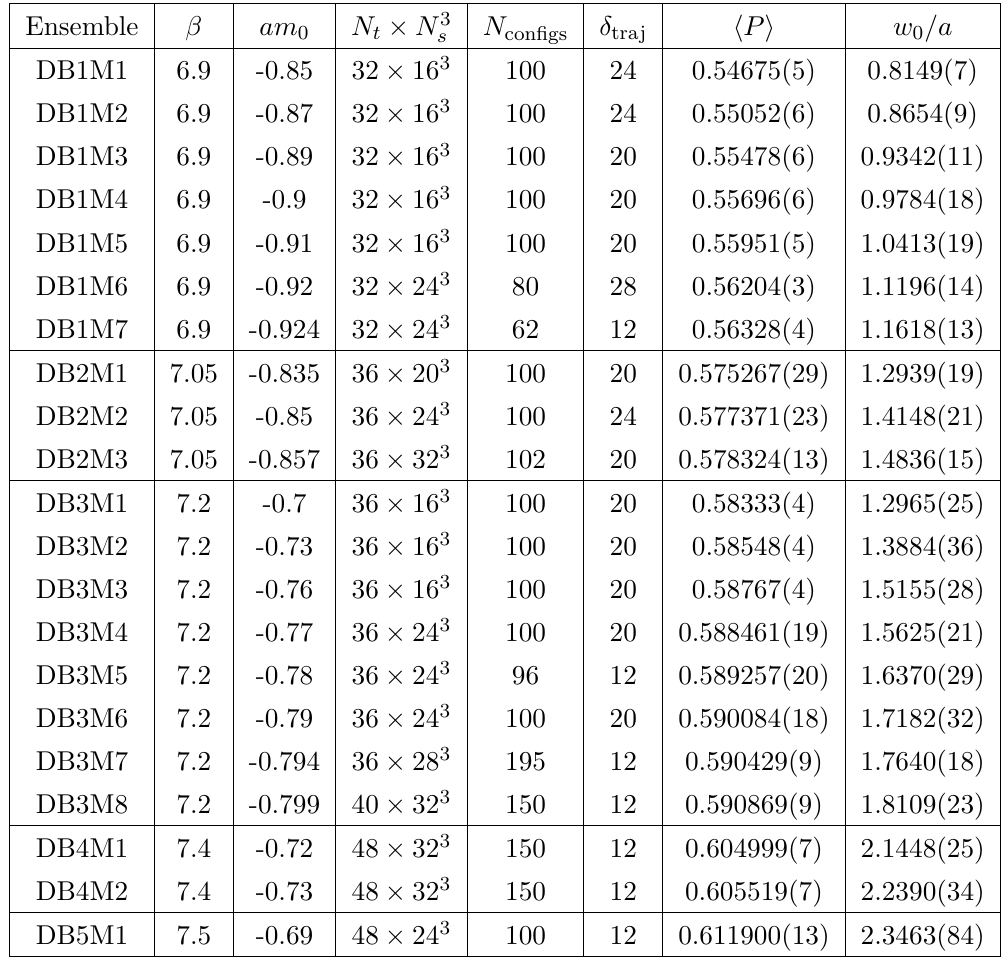
Table 1. List of ensembles generated for this study. The lattice parameters (cid:12) and am 0 are, respectively, the bare coupling and bare fermion mass. The lattice sizes are denoted by N t (cid:2) N 3 separately highlighting the time-like and space-like dimensions. The number of con(cid:12)gurations used to estimate the average plaquette h P i and the gradient (cid:13)ow scale w 0 =a is denoted by N con(cid:12)gs . The separation of trajectories between adjacent con(cid:12)gurations is denoted by (cid:14) traj . In the results for h P i and w 0 =a , in parenthesis we indicate the statistical